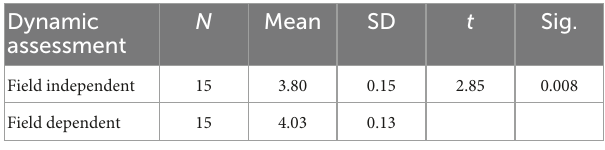
TABLE 3 Descriptive and independent sample t -test for posttest mean scores of field independent and field dependent learners with dynamic